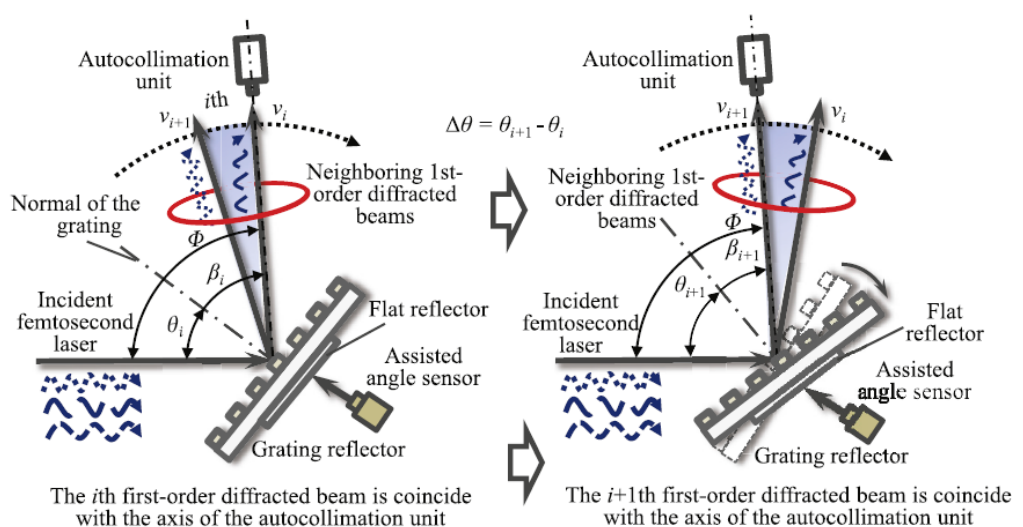
Figure 9. Absolute angular position measurement by the mode-locked femtosecond laser autocollimator based on the principle of the optical frequency-domain angle measurement with the enhancement of an assisted angle sensor [57]. In the setup, the angle of the normal of the grating reflector with respect to the incident femtosecond laser is a final measurand.